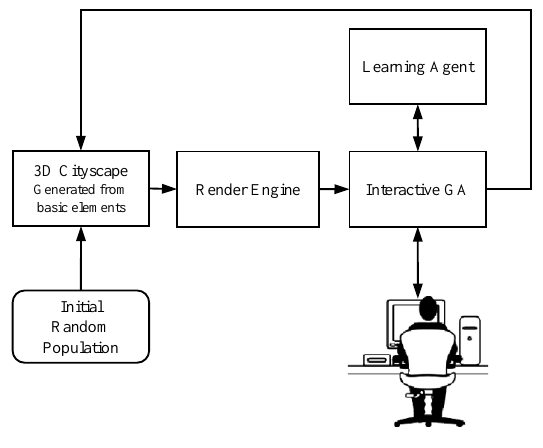
Figure 1. Human-Based GA